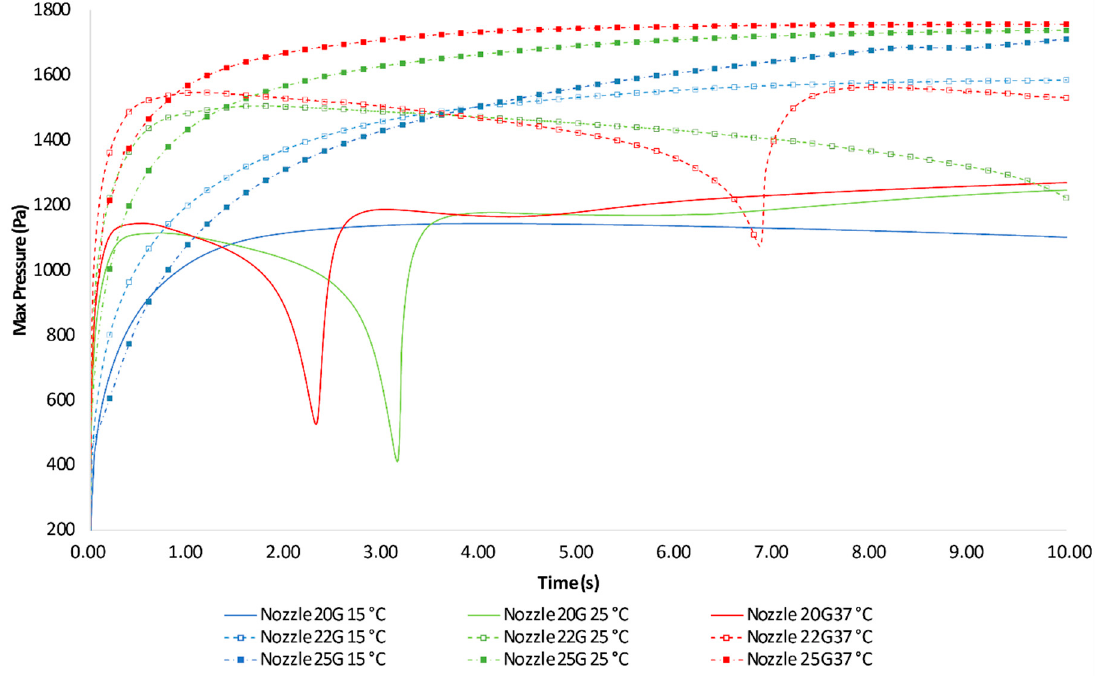
Figure 4. Maximum outlet pressure for 20, 22, and 25G conical tips using Cellink Bioink at 15, 25, and 37 °C.